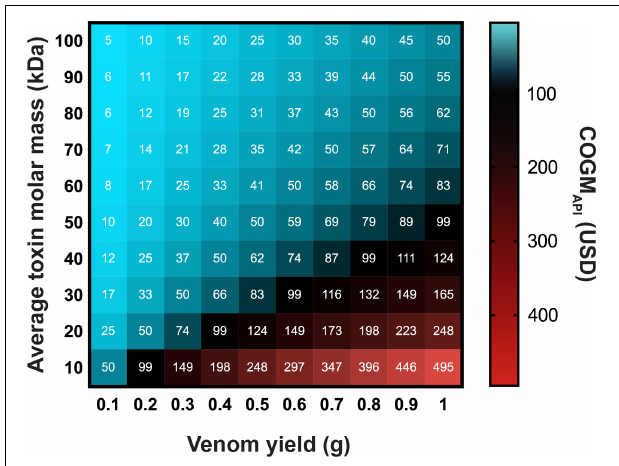
FIGURE 3 | How the molecular weight and amount of venom to be neutralized affect the Cost of Goods Manufactured of the Active Pharmaceutical Ingredient (COGM API ) for recombinant antivenoms. The heat map includes three variables, namely the amount of venom to be neutralized in grams, the average molecular mass of the venom toxins in kDa, and the COGM API in USD. The white numbers in the cells correspond to the exact COGM API corresponding to that particular